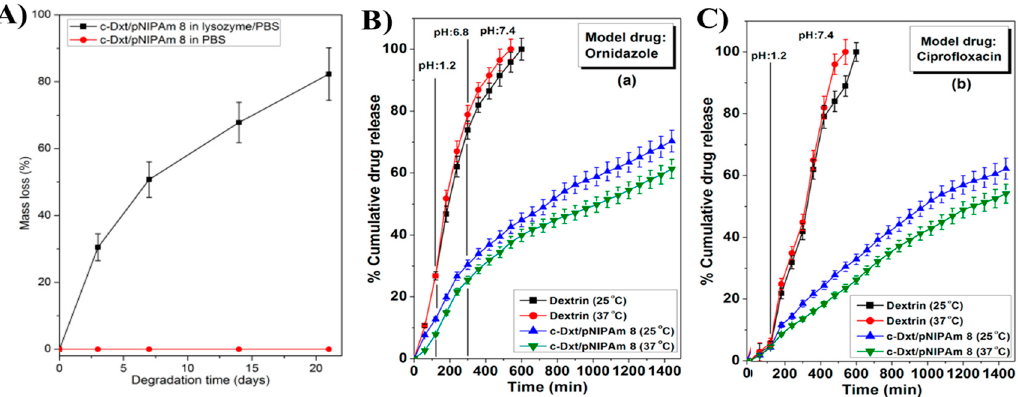
Figure 9. ( A ) Progressive mass loss of c-Dxt/PNIPAAm 8 xerogel films ( ■ ) in lysozyme/PBS and ( ● ) in PBS only; ( B ) IOn vitro release of ornidazole from dextrin and c-Dxt/PNIPAAm 8; ( C ) In vitro release of ciprofloxacin from dextrin and c-Dxt/PNIPAAm 8. “Dxt” refers to dextrin biopolymer, whereas the letter “c” refers to covalently cross-linked hydrogel and the number 8 is related to the molar ratio described on Table 1 inside the article. Results represented are mean ± SD, n = 3. Reprinted with permission from reference [86]. Copyright © 2015 American Chemical Society.